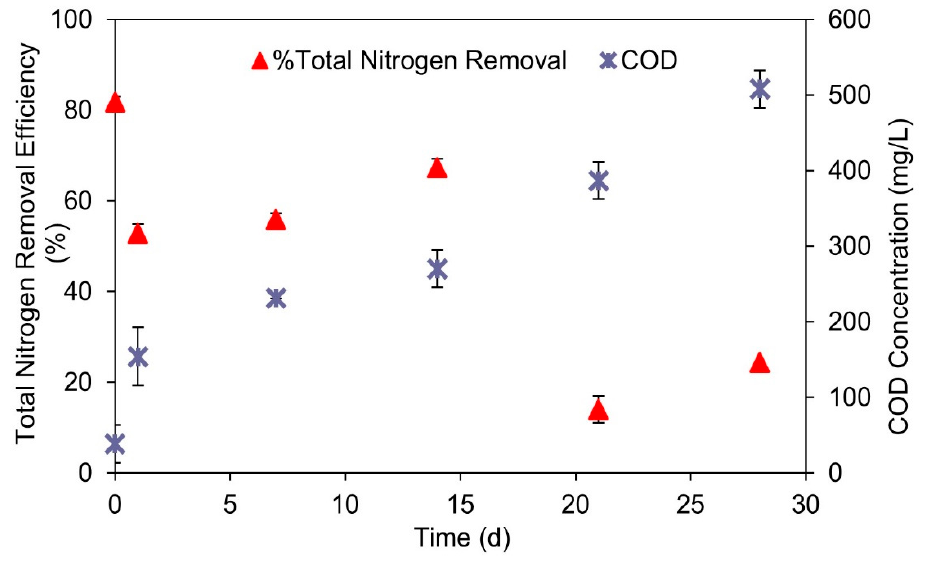
Figure 6. Total nitrogen removal efficiency and COD concentration for the anammox system to treat coffee wastewater.